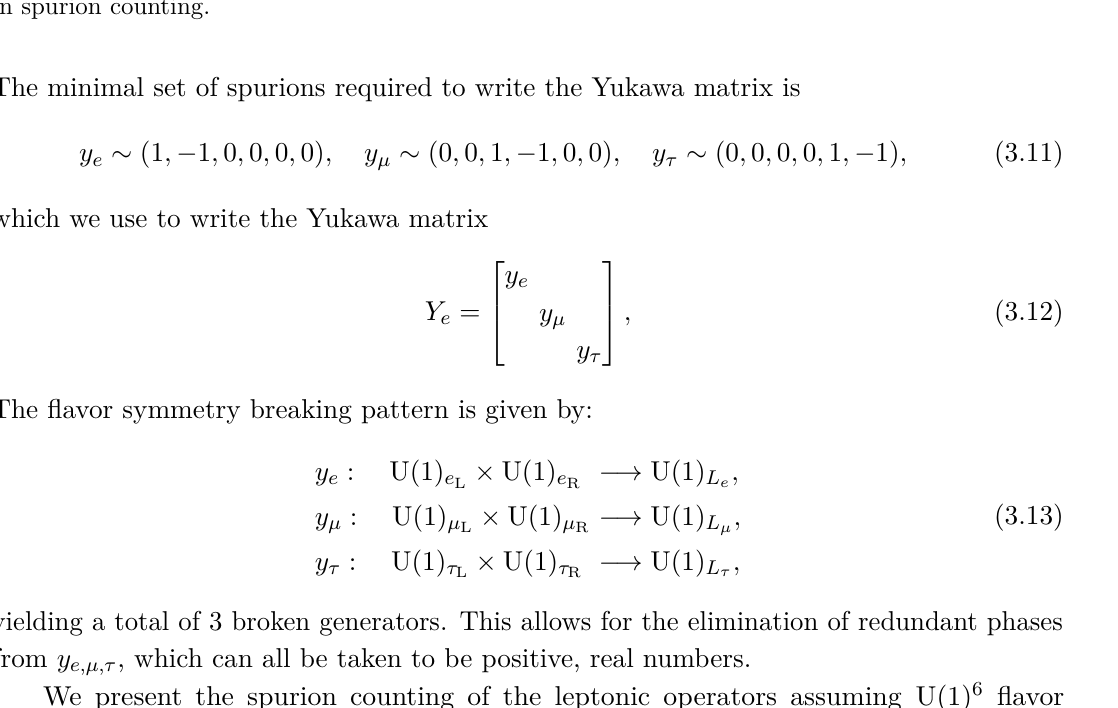
Table 8 . Counting of the pure lepton SMEFT operators (see appendix A) assuming U(1) 6 symmetry in the lepton sector. The counting is performed taking up to one insertion of y e,µ,τ spurion. The left (right) entry in each column gives the number of CP even (odd) coefficients at the given order in spurion